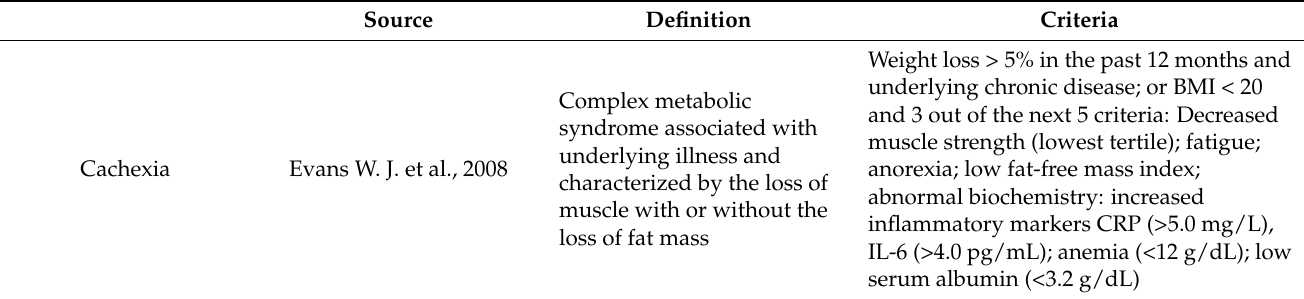
Table 1. The evolving concept of cachexia. Listed here are the criteria for the diagnosis of malnutrition, precachexia, and cachexia, including its severity with (from left to right): the corresponding reference, the definition of the cachectic status, and highlights of the main diagnostic criteria used. Cachexia was initially distinguished from anorexia or malnutrition, and, over the years, the progressive nature of muscle wasting (and its relevance to survival) has been highlighted. Ultimately, a staging was proposed for the severity of cachexia depending on the initial status of the